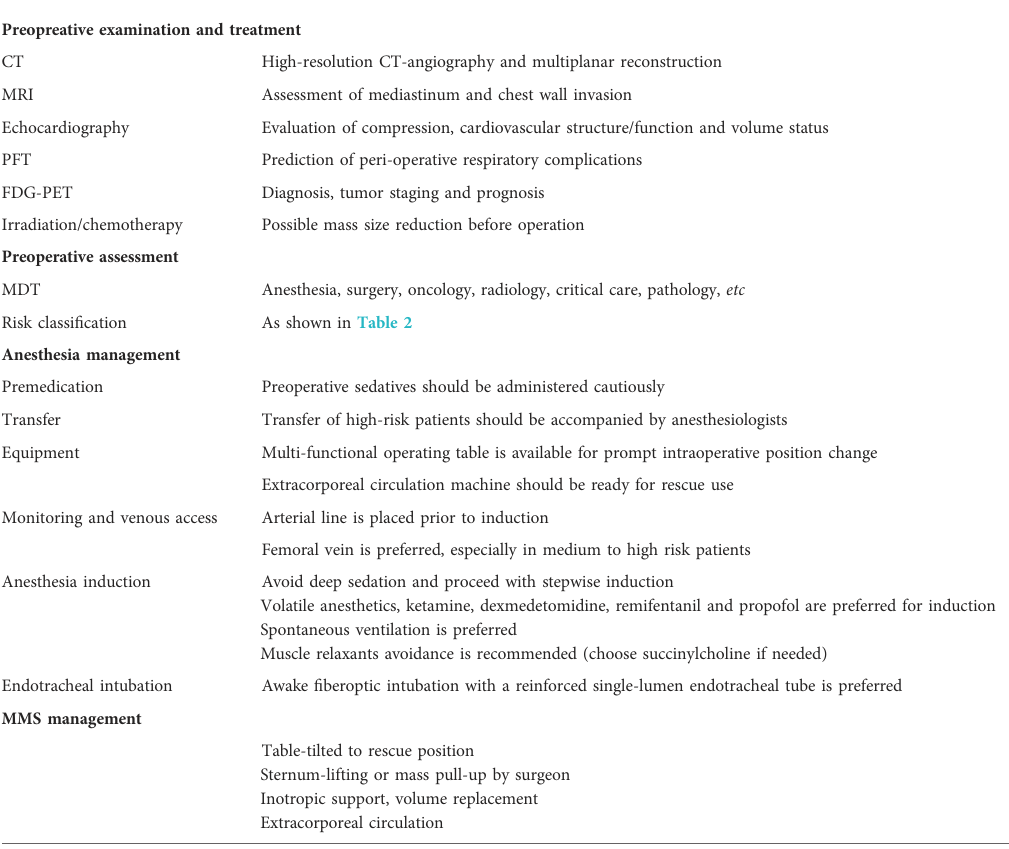
TABLE 3 Recommended management of patients undergoing mediastinal mass operation.